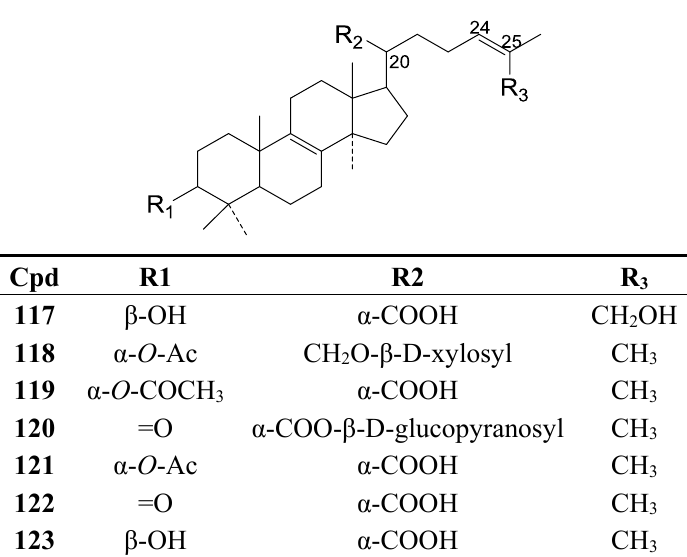
Figure 9. Structures of compounds 117 ‒ 123 .